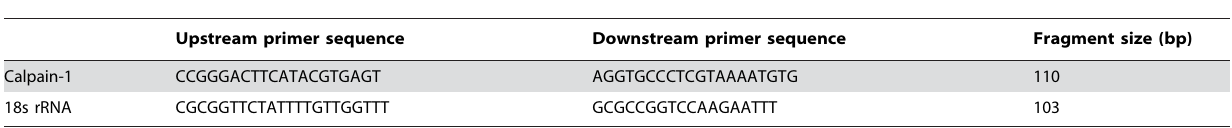
Table 1. Primers sequences and amplified fragments size used for real-time PCR